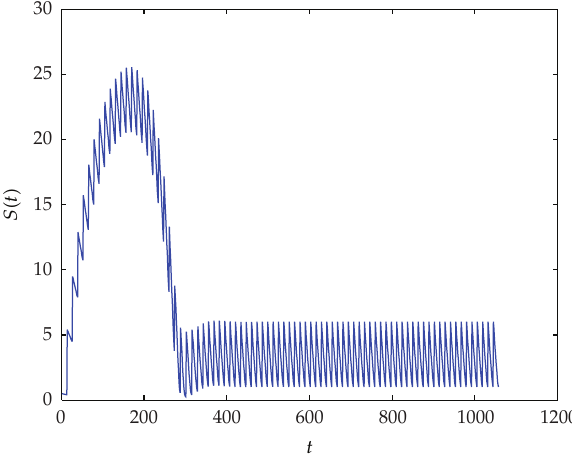
Figure 16: Time series of S (cid:3) t (cid:4) with parameters ρ (cid:7) 5 , μ (cid:7) 0 . 1 , β (cid:7) 1 , α (cid:7) 1 , r (cid:7) 0 . 3 , d (cid:7) 0 . 2 , ω (cid:7) 0 . 2 , T (cid:7) 0 . 8 , and τ (cid:7) 0 . 2.